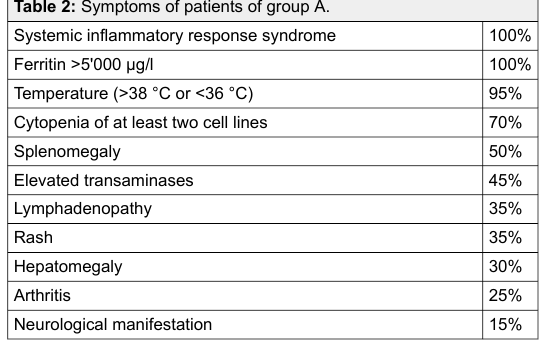
Table 2: Symptoms of patients of group A.